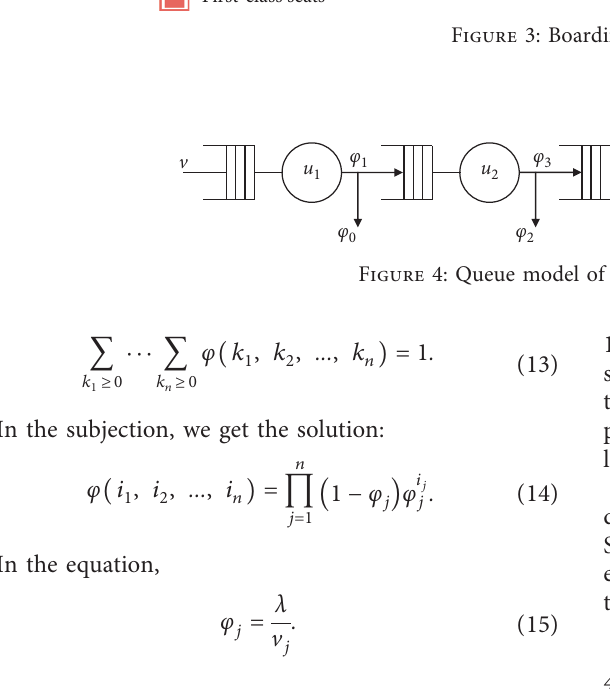
Figure 3: Boarding process.